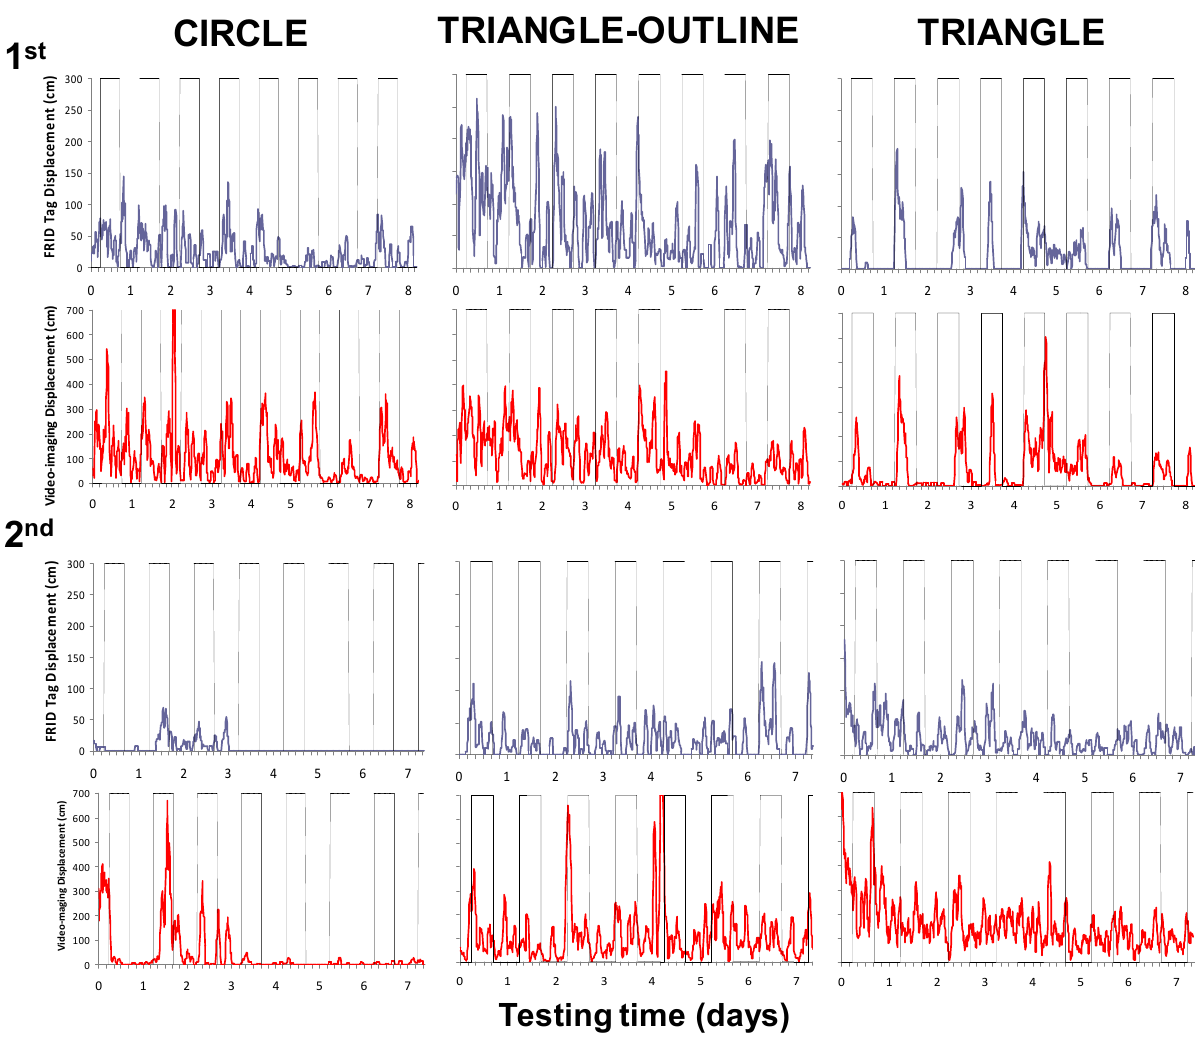
Figure 4. Time series of recurred distances by 6 individuals of Nephrops tracked by RFID (blue) and automated video imaging (red) in a day-night photoperiod regime (vertical grey rectangles indicate the night duration), during the first (1st) and the second (2nd) experiment.